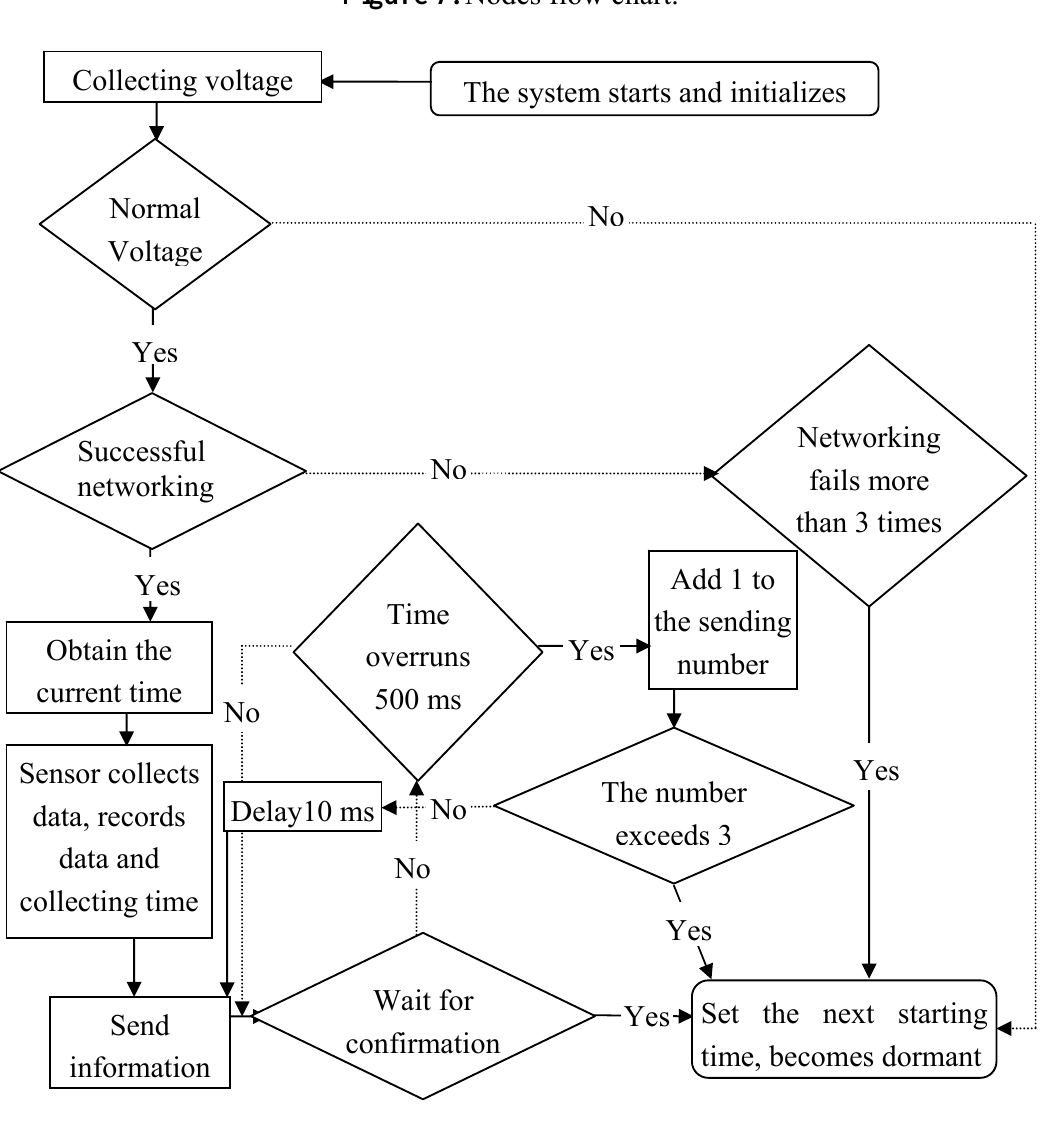
Figure 7. Nodes flow